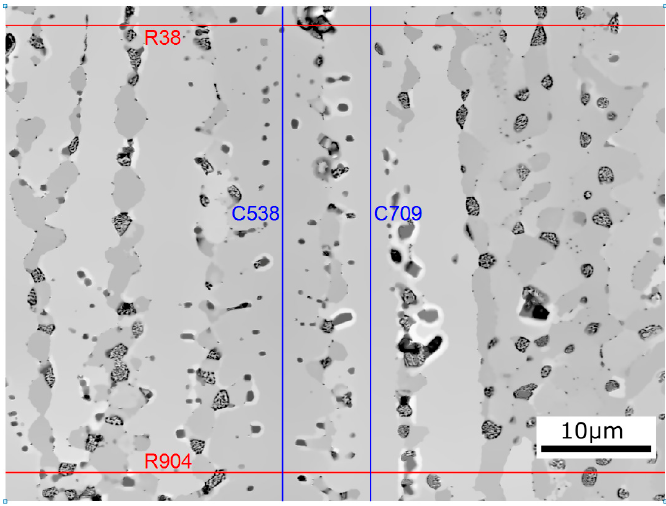
Figure 11. Denoised microscopic image with the drifts and multiple backgrounds.